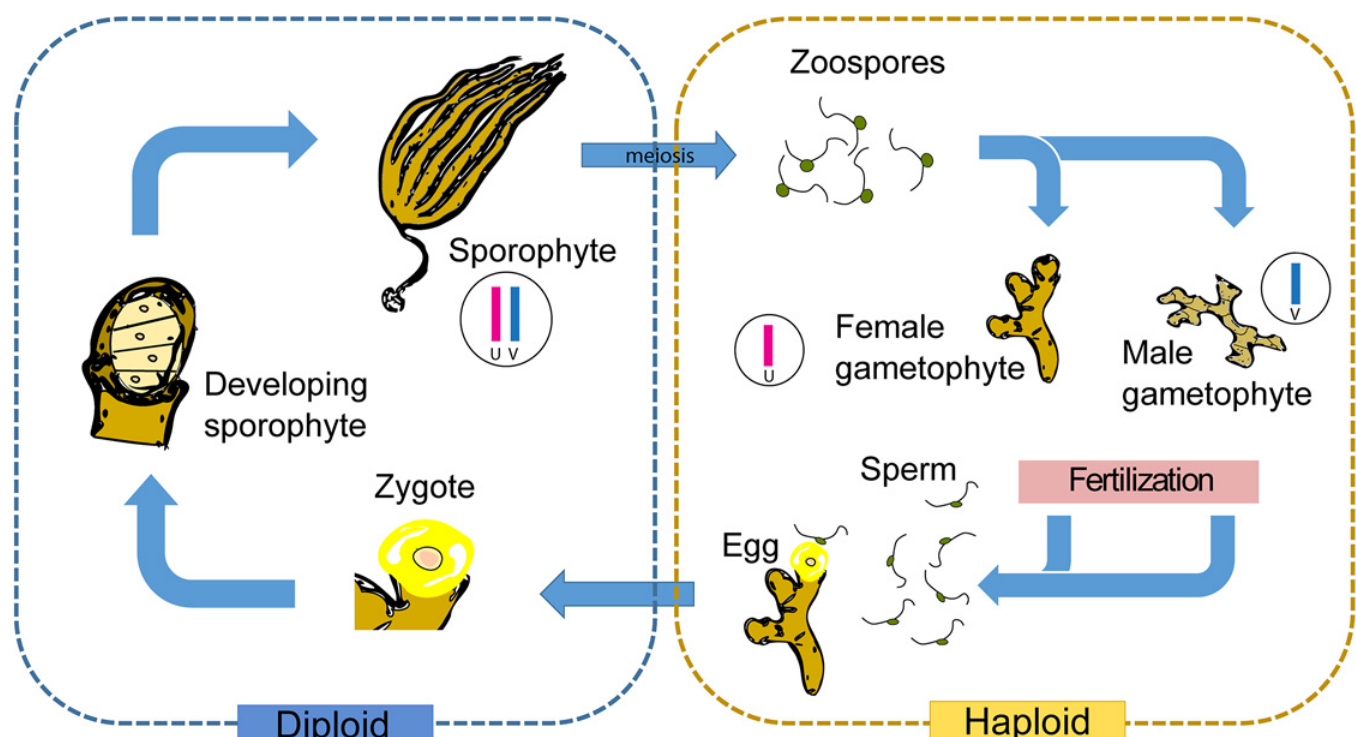
Fig 1. Schematic representation of a kelp life cycle. The sexual cycle consists of an alternation between a macroscopic diploid sporophyte and microscopic, haploid, dioicous (male and female) gametophytes. The zoospores produced by the sporophyte are released and develop as male (carrying the V sex chromosome) or female (carrying the U sex chromosome) gametophytes. Egg and sperm produced by the gametophyte fuse to return to the diploid, asexual sporophyte generation, which carries both the U and the V sex chromosomes.